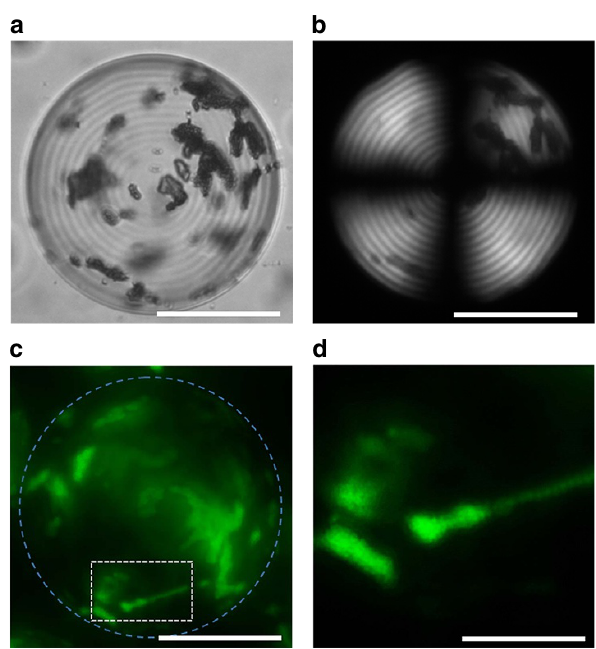
Figure 6 | Ch-CNC droplets loaded with 1000nm latex particles. ( a ) BF, ( b ) POM and ( c ) FM images of aggregates of 1,000nm latex particles in the Ch-CNC droplets with f 0 ¼ 0.043. f NP ¼ 0.0052. ( d ) Enlarged FM image of the latex particle aggregates shown in the white box in c . The scale bar is 50 m m in a – c and 15 m m in d